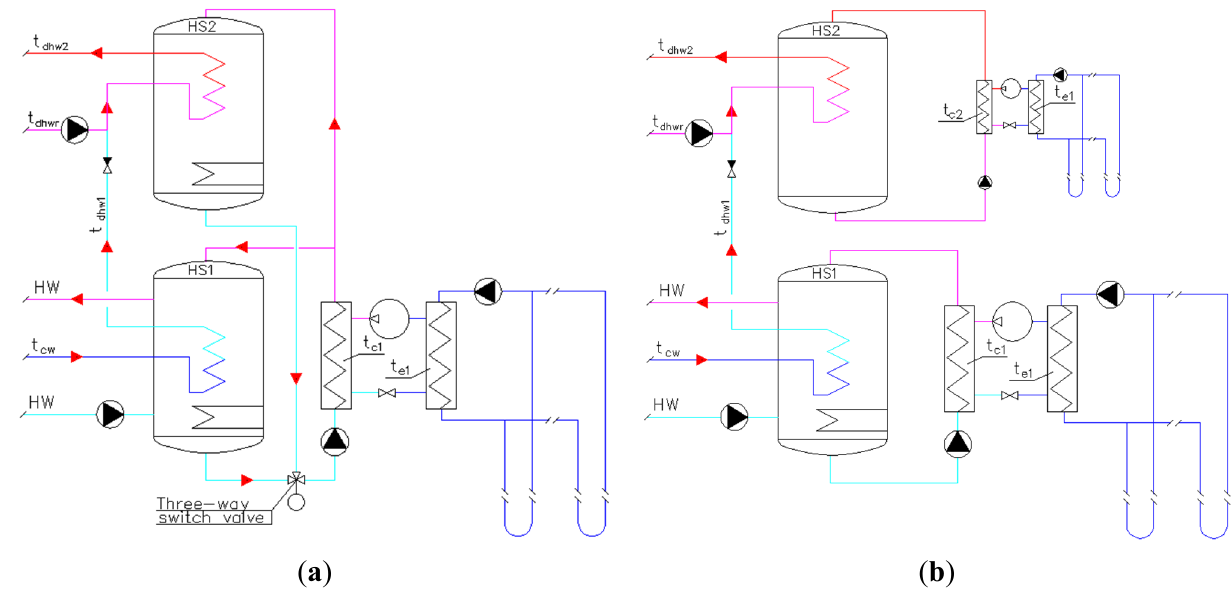
Figure 2. DHW production: ( a ) System 3; and ( b ) System 4.